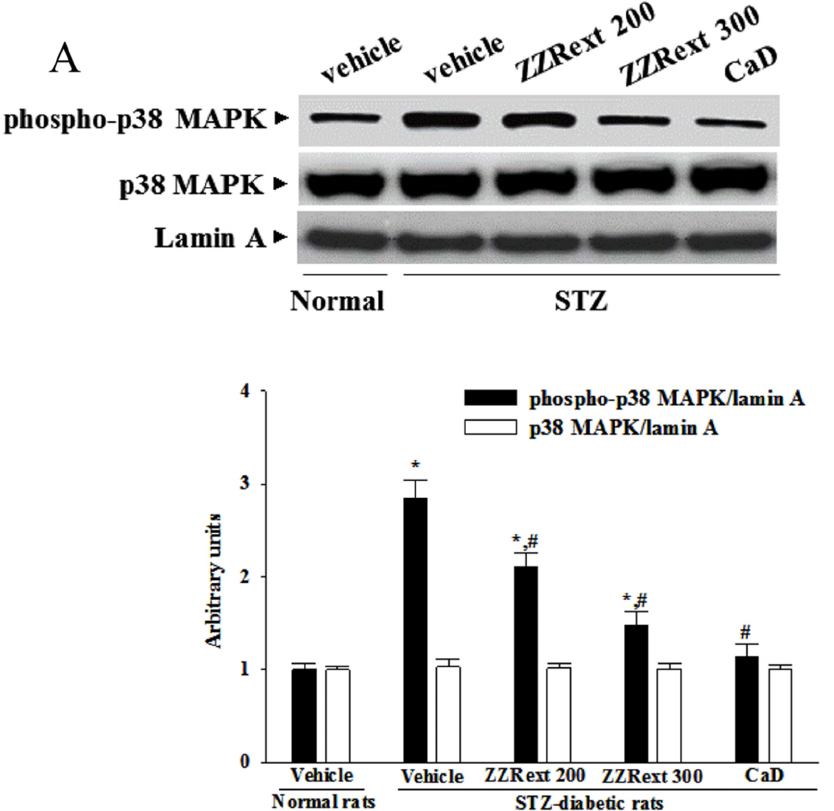
Figure 4. Figure 4. Cont.